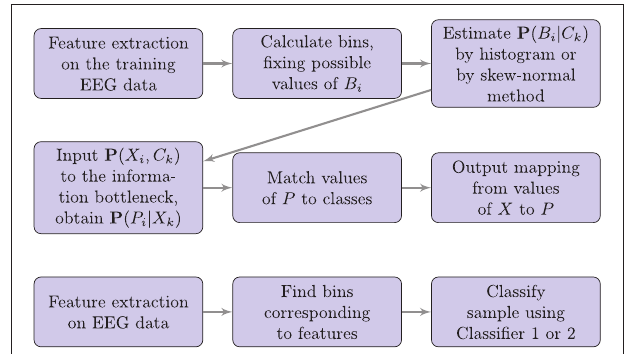
FIGURE 1 | Flowchart of the proposed method. Here P denotes the predicted class, C denotes the correct class, B denotes the bin corresponding to the feature value, and X denotes the vector of bins, as defined in sections 2.4–2.6. The upper diagram shows the training process; the lower diagram shows the testing or real-time